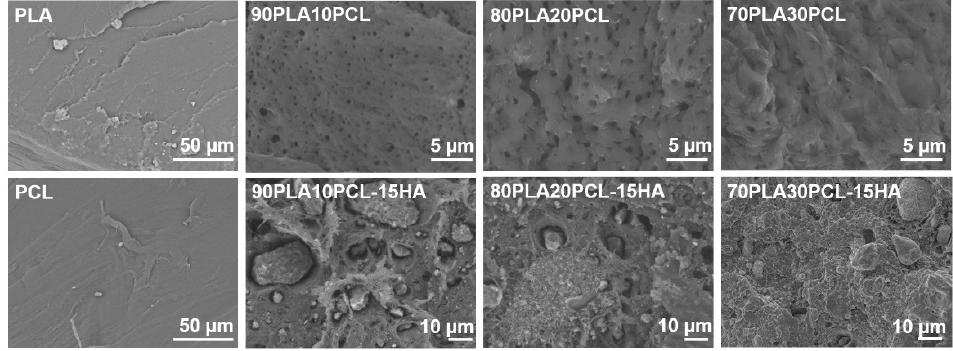
Figure 2. Scanning electron microscopy (SEM) images of filament cross sections for each material.